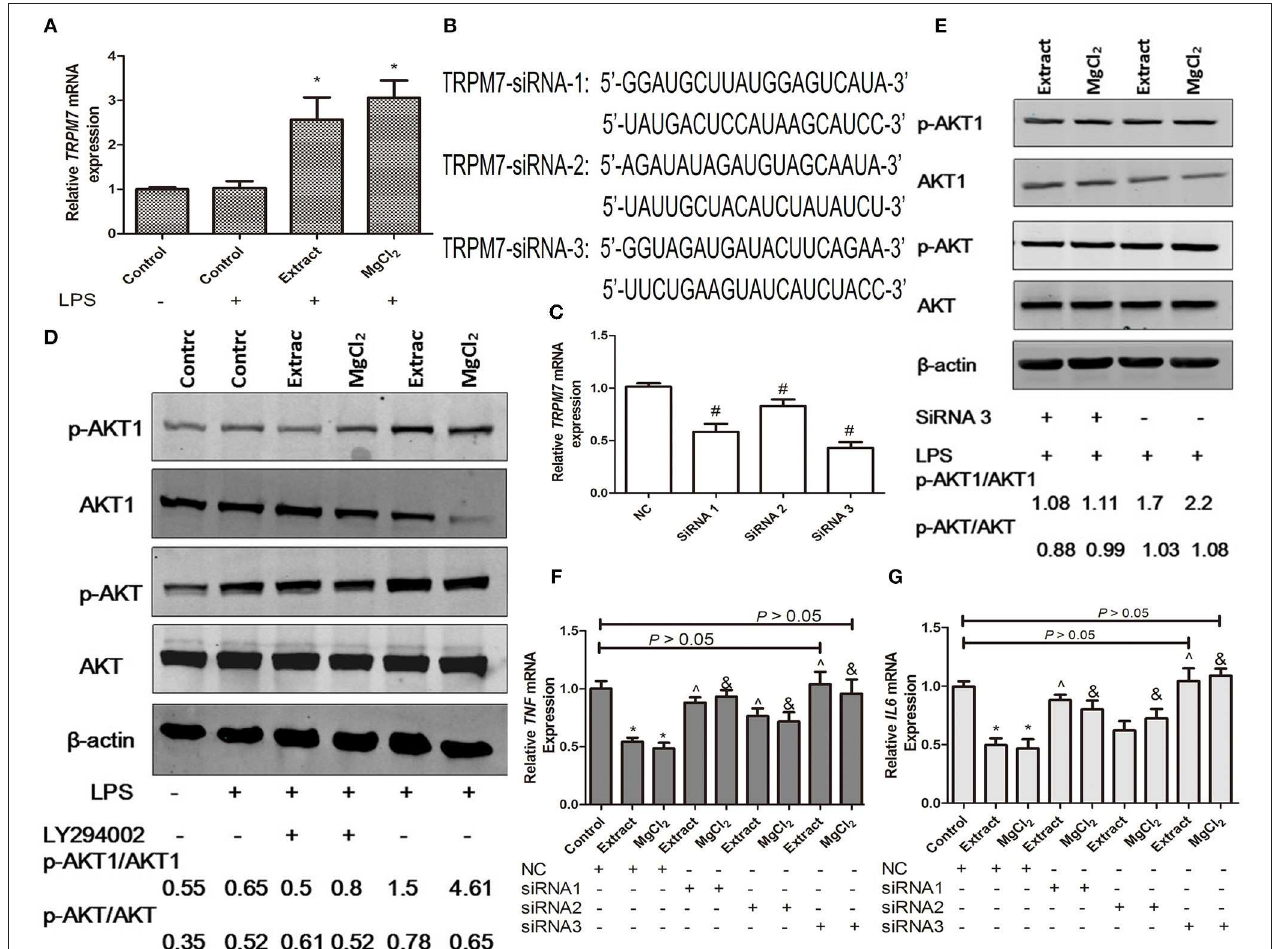
FIGURE 9 | Effects of extract and MgCl 2 on the TRPM7–PI3K–AKT1 anti-inflammatory signaling pathway in macrophages. (A) The mRNA expression of TRPM7 in THP-1 cell-derived macrophages cultured with extract or MgCl 2 for 1h prior to the addition of LPS for 6h was determined by qPCR. (B,C) THP-1 cell-derived macrophages were, respectively, transfected with TRPM7-siRNAs (TRPM7-siRNA1, TRPM7-siRNA2, and TRPM7-siRNA3) plasmids for 72h, and the mRNA expression of TRPM7 was determined by qPCR. (D) THP-1 cell-derived macrophages were pretreated with extract or MgCl 2 in the presence or absence of LY294002 (10mM) for 1h prior to stimulation with LPS for 45min. The relative expression of p-AKT/AKT and p-AKT1/AKT1 was determined by western blotting. (E) THP-1 cell-derived macrophages were transfected with TRPM7-siRNA3 or NC (no plasmid content) for 72h and then incubated in the presence or absence of extract or MgCl 2 for 1h prior to stimulation with LPS for 45min. The relative expression of p-AKT/AKT and p-AKT1/AKT1 was determined by western blotting. The transfected THP-1 cell-derived macrophages were pretreated with or without extract or MgCl 2 for 1h prior to stimulation with LPS for 6h and the mRNA expression of TNF (F) and IL-6 (G) was analyzed by qPCR. The representative images from three experiments are shown. * P < 0.05 vs. LPS control group or NC-control group; ∧ P < 0.05 vs. NC-extract group; # p < 0.05 vs. NC group; & P < 0.05 vs. NC-MgCl 2 group. LPS,